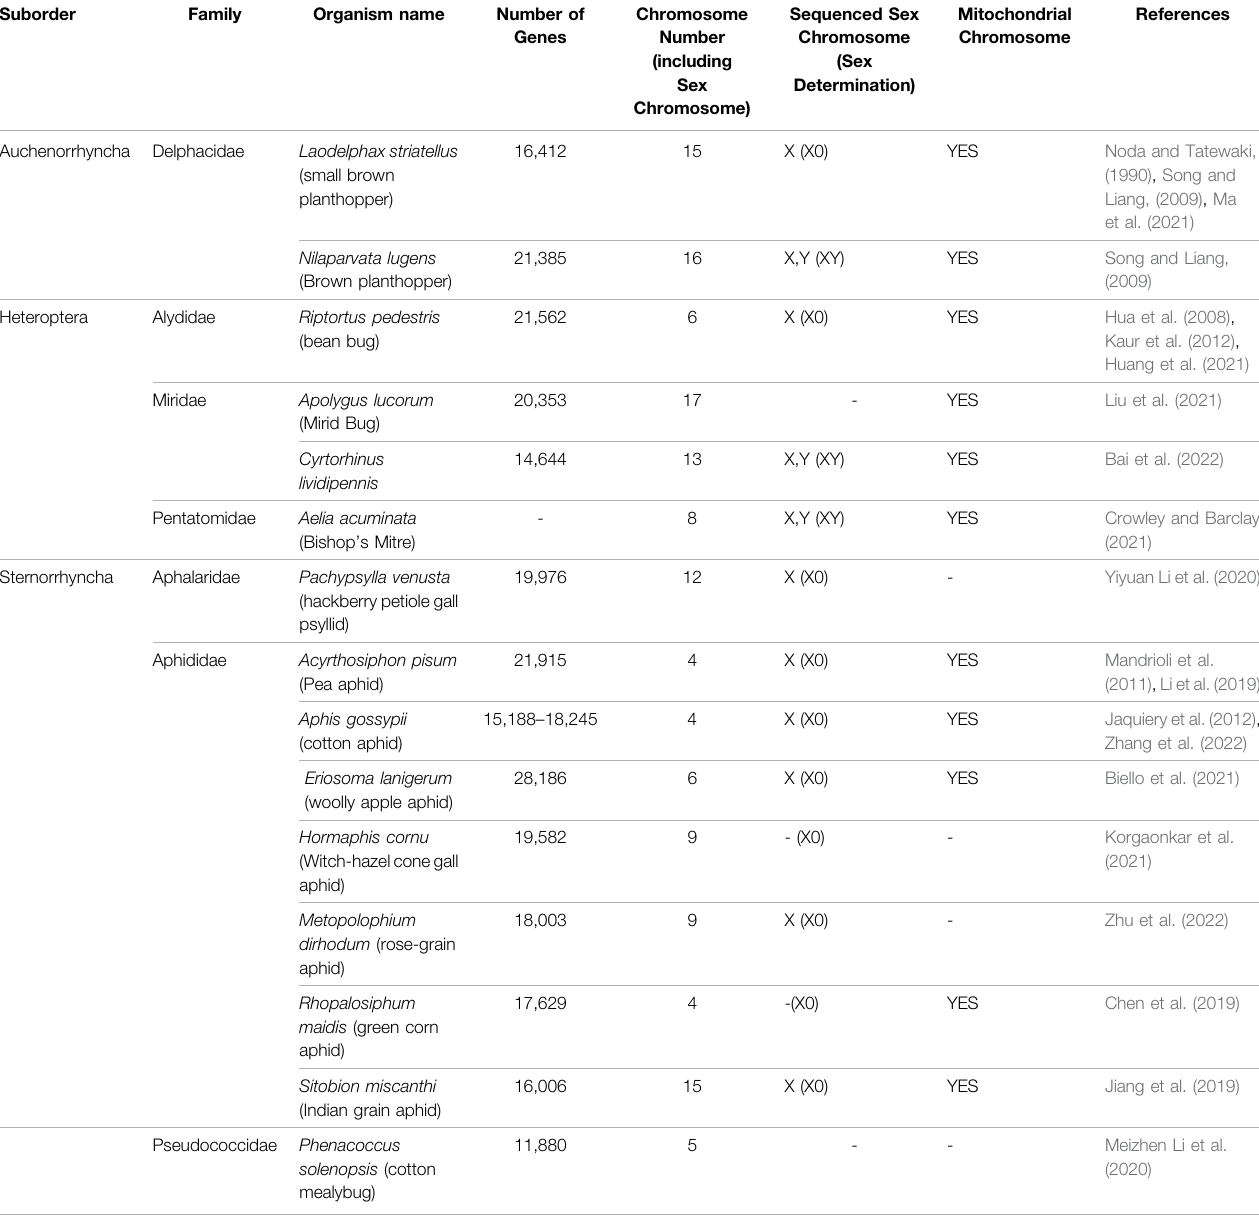
TABLE 1 | Chromosomal assembly genome projects in Hemiptera deposited at NCBI.